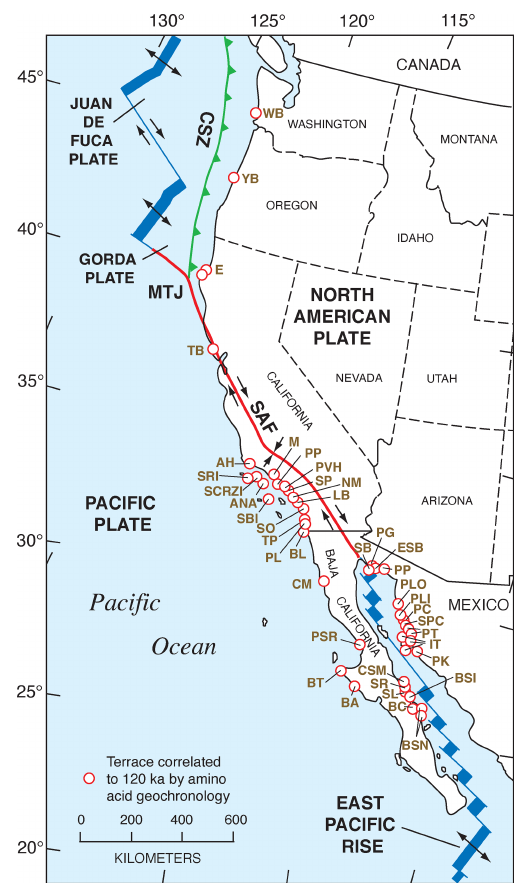
Figure 15. Map of the Pacific coast of North America with struc- tural features as shown in Fig. 2, but also plotted are localities (open red circles) where amino acid geochronology has permitted correla- tion of marine deposits to MIS 5e ( ∼ 120ka). Structural features are redrawn in simplified form from Drummond (1981) and Simkin et al. (2006). Abbreviations are keyed to Table S2 and are as follows: